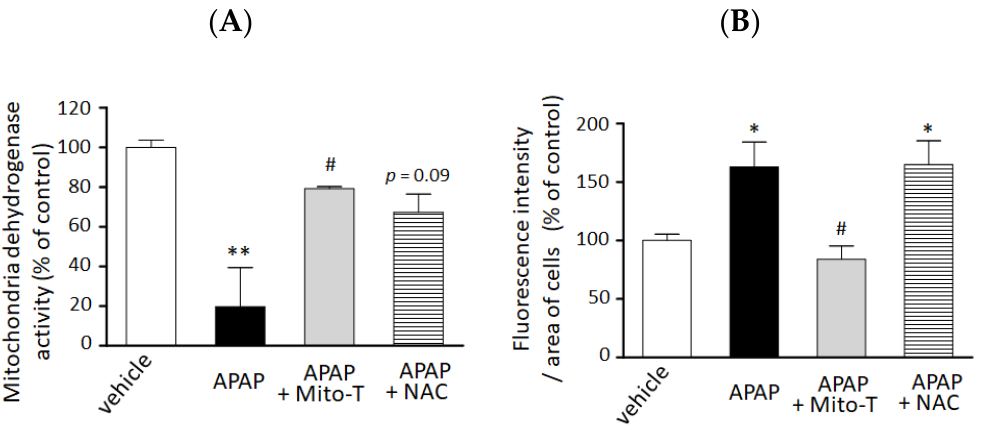
Figure 3. Preventive e ff ect of Mito T and NAC against APAP-induced cellular injury and mitochondrial oxidative stress in a 3D cultured HepG2 cell model. HepG2 cells cultured in NCP (3D-NCP HepG2 cells) were exposed to 15 mM APAP in the presence or absence of Mito-T (10 µ M) or NAC (100 µ M). The reagents were added just after cell exposure to APAP. ( A ) Cell viability was measured 24 h after APAP exposure by changes in mitochondrial dehydrogenase activity using the WST-8 assay kit. Each bar represents the mean ± SEM ( n = 3). ( B ) MitoSOX (5 µ M) was added for 15 min after 24 h exposure to APAP. The cells were imaged at excitation / emission wavelengths of 490 / 510 nm and under bright field using a microscope. Random fields from each well were analyzed by microscopy, and the fluorescence of MitoSOX was quantified using ImageJ software (1.47v). Control or vehicle groups were treated with DMEM medium only. Each bar represents the mean ± SEM ( n = 5). * p < 0.05, ** p < 0.01 vs. the vehicle group, # p < 0.05 vs. the APAP